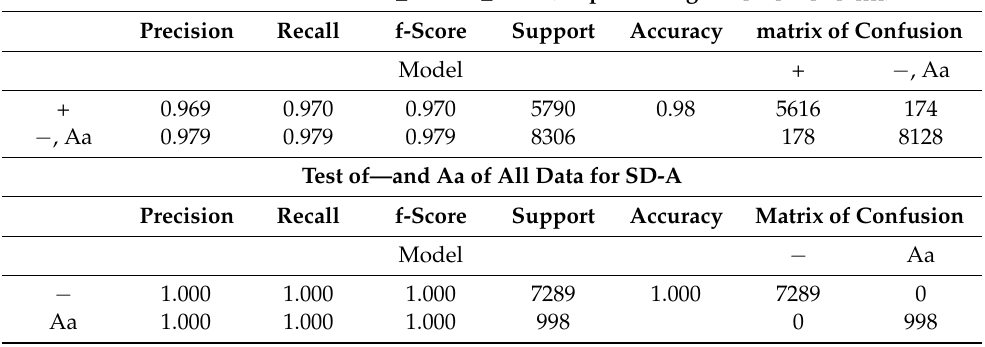
Table 7. Confusion matrix and evaluation criteria for the test using all data for the SB-model_ DSML_LDA and the